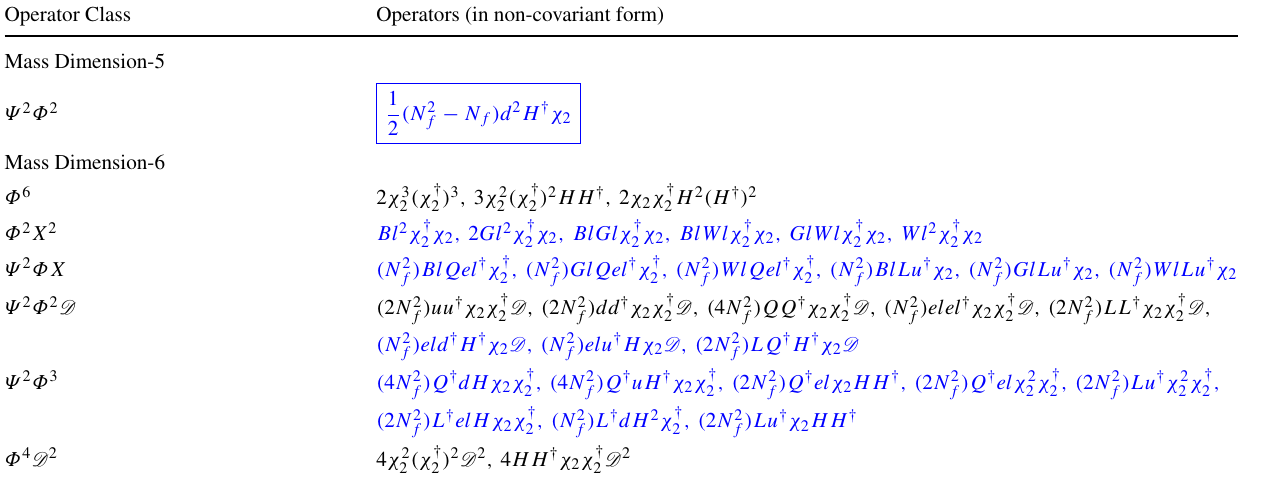
Table 40 Lepto-quark model 2( χ 2 ): operators of mass dimensions-5 and -6 excluding pure SM operators Operator